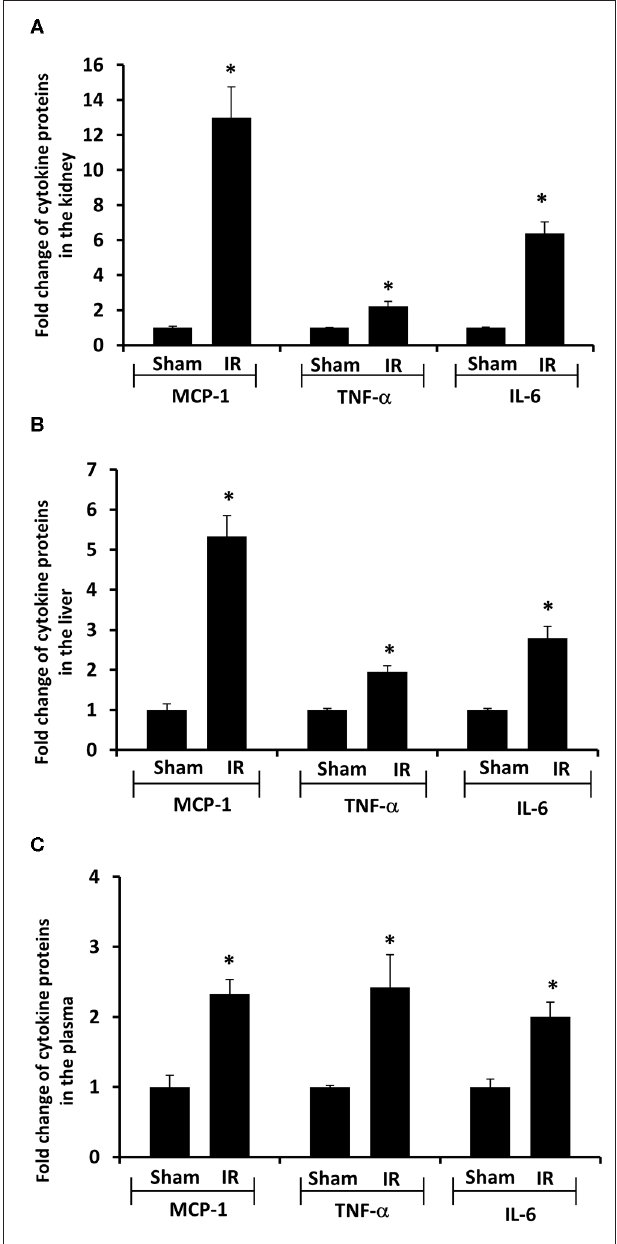
FIGURE 4 | Effect of kidney ischemia-reperfusion on cytokine protein levels in the kidney, liver, and plasma. The left kidney of rats was subjected to 45min ischemia followed by 6 hours (6h) of reperfusion (IR). As a control, rats were subjected to a sham-operation without inducing ischemia (Sham). The protein expressions of MCP-1, TNF- α , and IL-6 were measured in the kidney (A) , liver (B) , and plasma (C) by using ELISA. For reference, the cytokine levels in the sham group were MCP-1 (kidney 3.9 ng/g tissue, liver 100 pg/g tissue, plasma 13.63ng/ml), TNF- α (kidney 200 ng/g tissue, liver 41 pg/g tissue, plasma 1.2 pg/ml), IL-6 (kidney 3.2 ng/g tissue, liver 1,880 pg/g tissue, plasma 1.8 pg/ml). Results are expressed as fold change to the Sham ( n = 5 for each group). * p < 0.05 when compared with the value obtained from the sham-operated